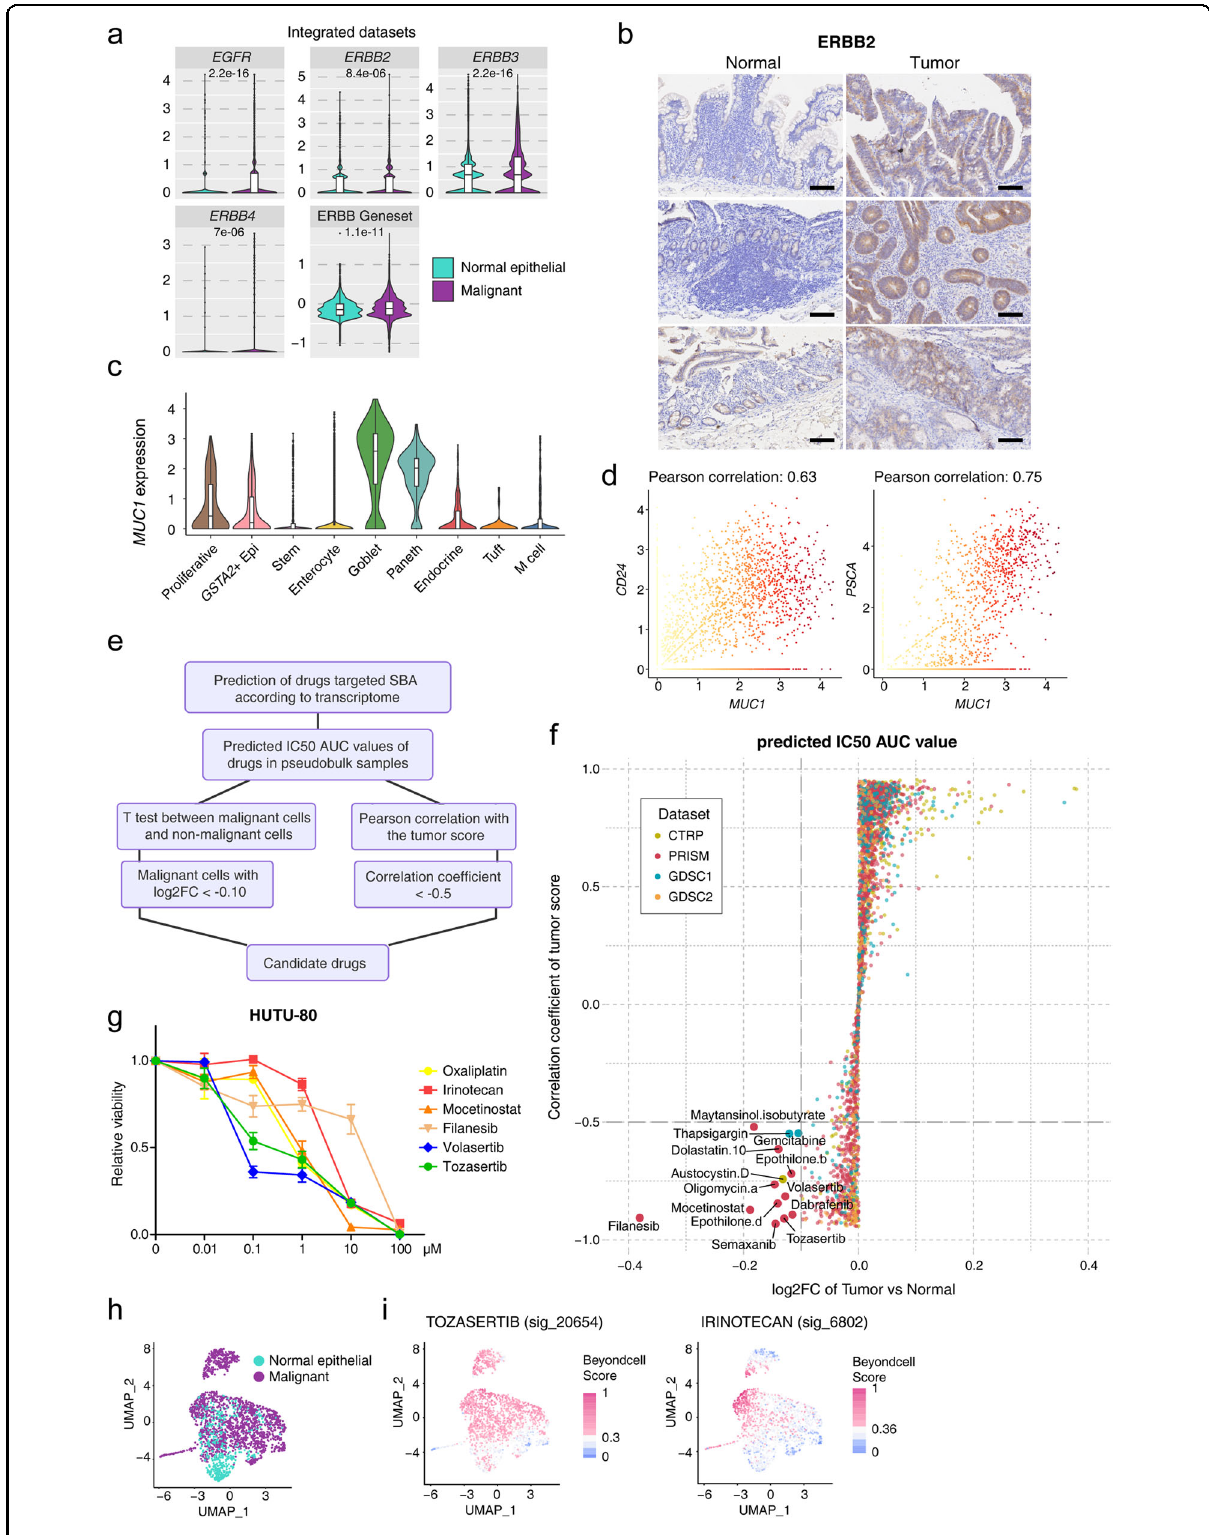
Fig. 7 (See legend on next